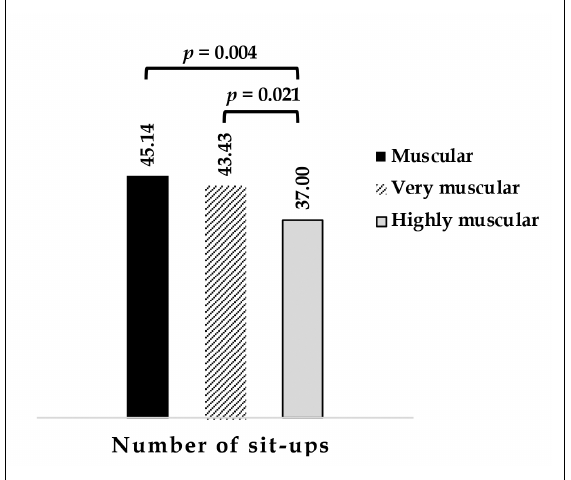
Figure 4. Differences in number of executed SU between the BMI